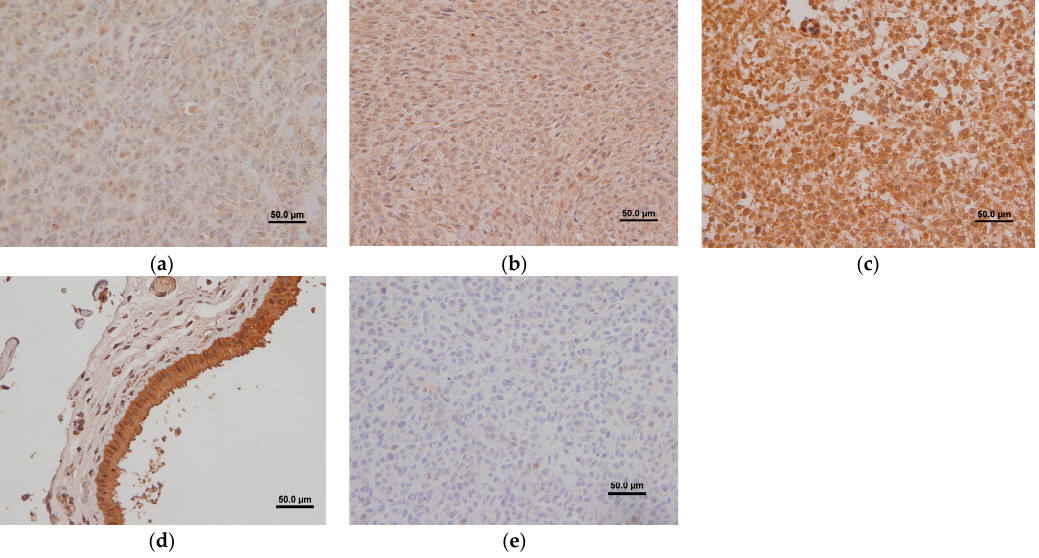
Figure 1. IHC of paraffin-embedded canine appendicular OS with 2G11 mAb: ( a ) representing a weak staining intensity; ( b ) representing a moderate staining intensity; ( c ) representing a strong staining intensity; ( d ) canine paraffin-embedded placenta was used as the positive control; ( e ) non-specific mAb MOPC-21 was used on paraffin-embedded canine appendicular OS as the negative control. The CPD values are represented in Figure 2. For all dogs, median CPD value was 54.94 (25th percentile = 36.99; 75th = 70.75). CPD was not correlated with age ( p =